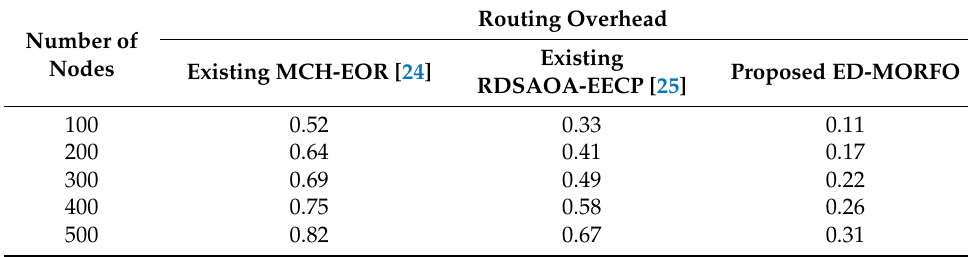
Table 7. Performances of routing overhead.